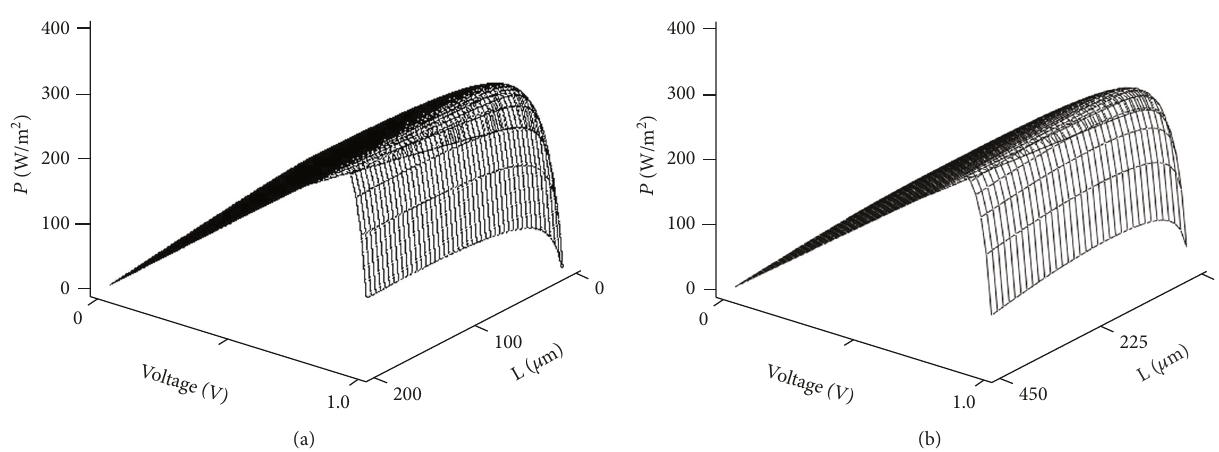
Figure 2: The output power density of a tandem cell versus voltage and the total thickness of the active layers for two ratios of subcell / L = 1/40 and (b) L / L = 1/100 . thickness: (a) L Cu 2 O c ‐ Si Cu 2 O c ‐ Si Table 3: The parameter values of the Cu O and c-Si subcells and the 2 tandem in the case of maximum output power density of the tandem cell.